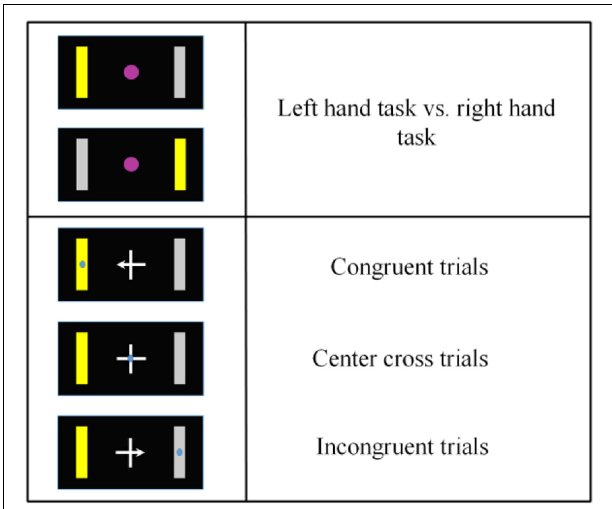
FIGURE 2 | Overview of motor imagery tasks and gaze shift and fixation tasks. According to the congruence between a motor imagery task and a gaze shift and fixation position, there were three different control conditions, i.e., congruent trials, center cross trials and incongruent